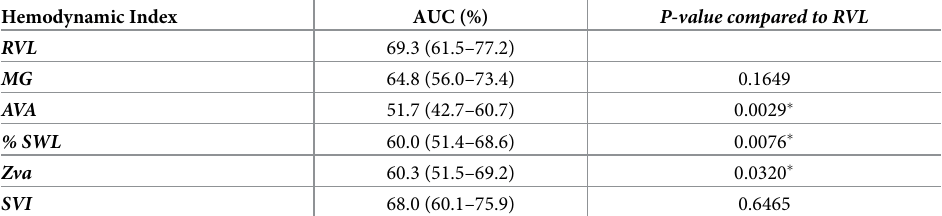
Table 2. Receiver Operator Curve Analysis of the hemodynamic indices for predicting all cause mortality 1-year post-TAVR. Hemodynamic Index AUC (%)